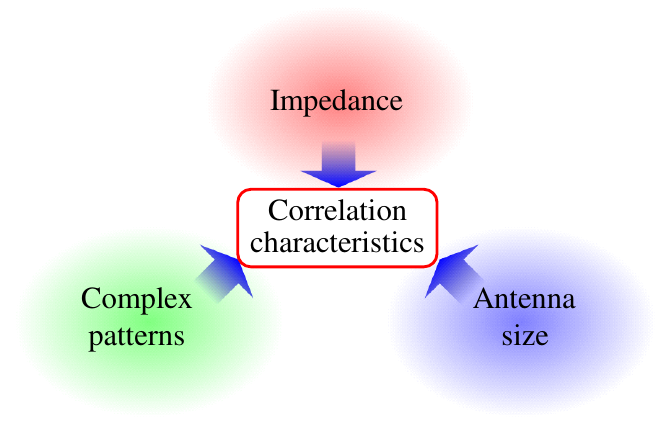
Figure 1. Impact of the antenna factors on correlation